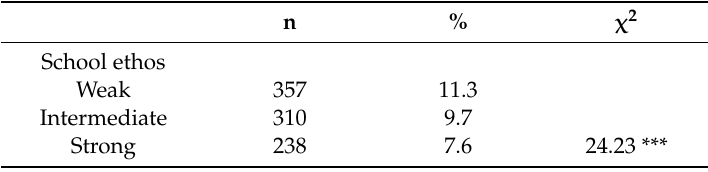
Table 2. Recurring sickness absence among students, by thirds of teacher-rated school ethos n = 9482.